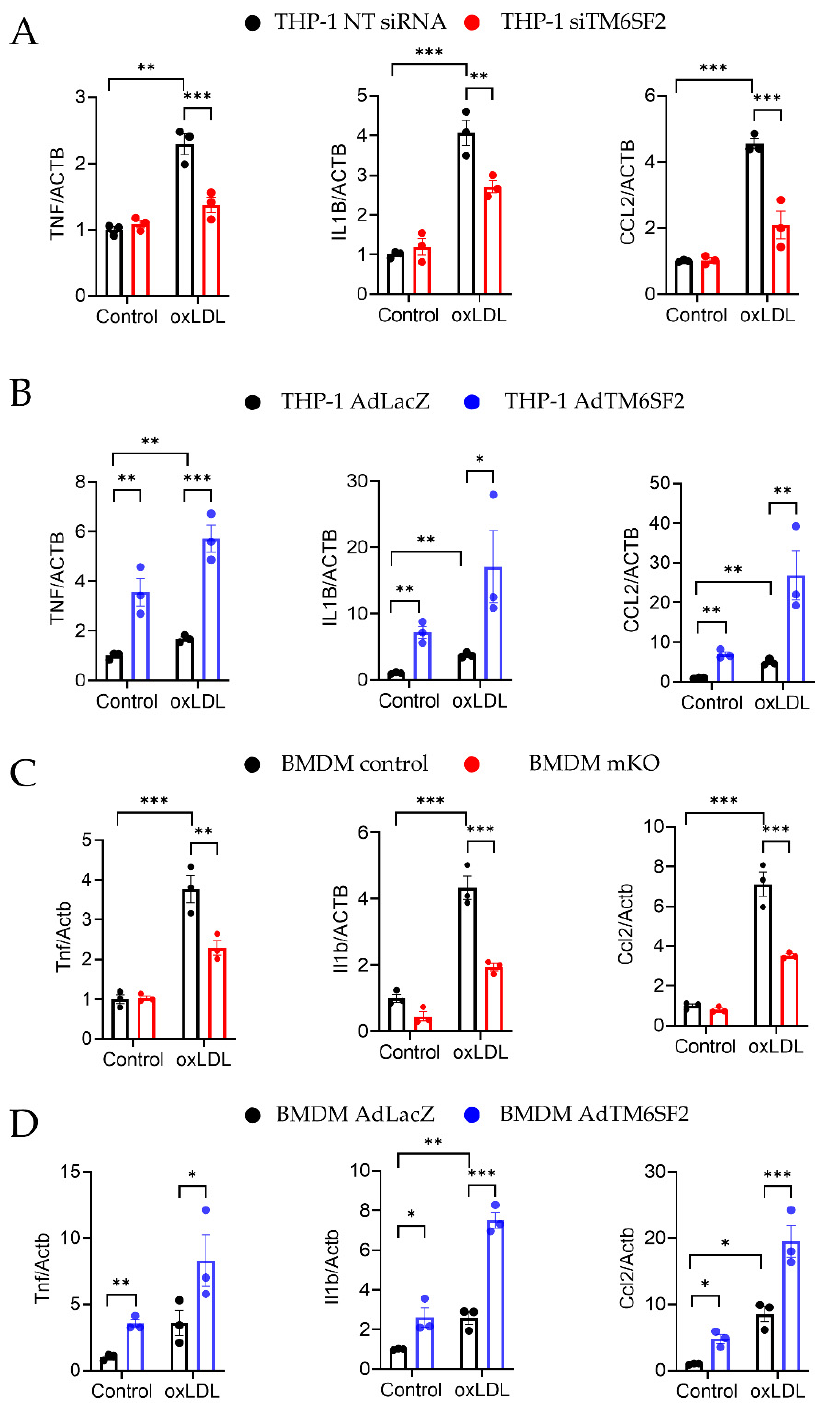
Figure 3. TM6SF2 Contributes to Inflammatory Responses in Macrophages. ( A ) THP-1-derived macrophages were transfected with TM6SF2 siRNA or NT siRNA (20 nM) for 48 h and treated with oxLDL (100 µ g/mL) for 4 h. ( B ) THP-1-derived macrophages were transfected with AdLacZ or AdTM6SF2 (100 MOI) for 48 h and treated with oxLDL (100 µ g/mL) for 4 h. ( C ) BMDMs were isolated from control and Tm6sf2 mKO mice and treated with oxLDL (100 µ g/mL) for 4 h. ( D ) BMDMs were isolated from wild type C57BL/6J mice and were transfected with AdLacZ or AdTM6SF2 (100 MOI) for 48 h and treated with oxLDL (100 µ g/mL) for 4 h. mRNA expression of TNF- α , IL1 β , and CCL2 were measured by qRT-PCR. n = 3 for each group. All data are presented as mean ± SEM, statistics by 2-way ANOVA. * p < 0.05, ** p < 0.01, *** p < 0.001 as